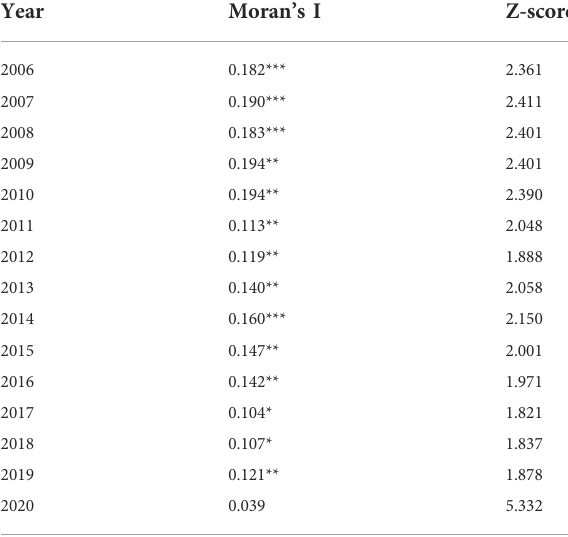
TABLE 4 Global Moran index of carbon emission intensity. TABLE 5 The impact of digital economy development on carbon